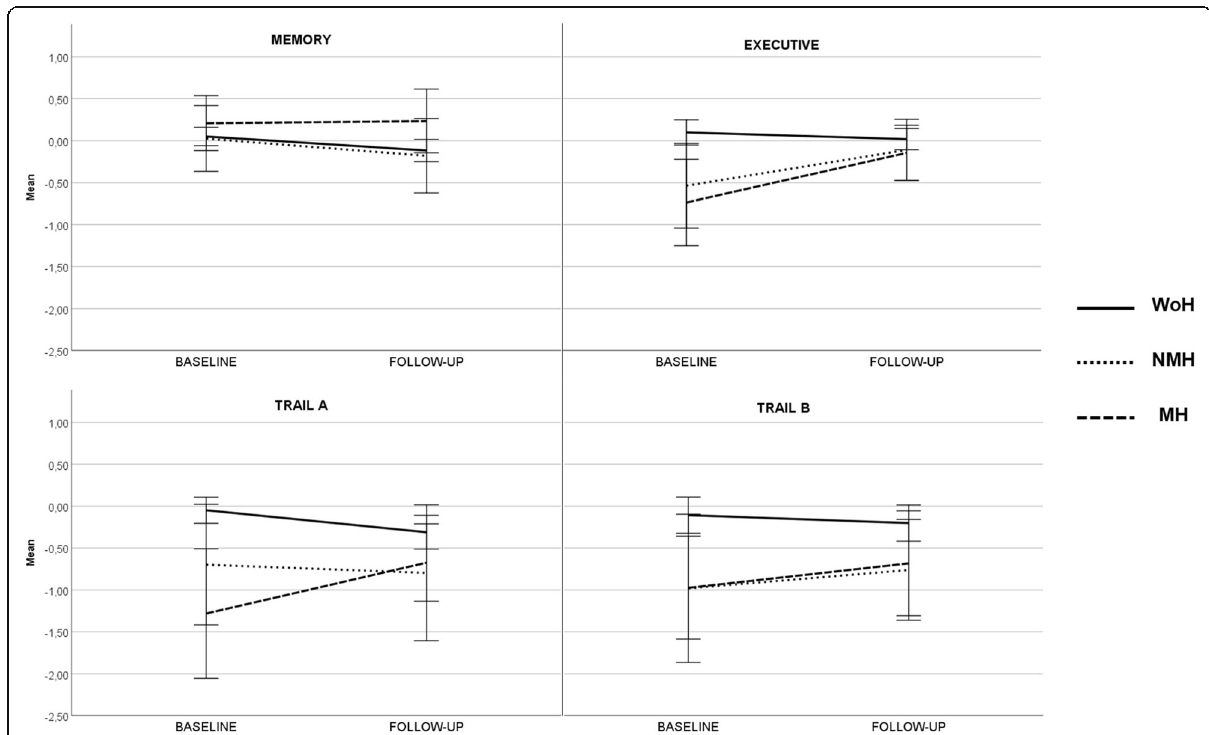
Fig. 3 Cognitive performance overtime by headache group. Legend: y-axis represent estimated marginal means memory and executive composite zscores and trail A and B zscores controlling for gender, age at baseline, depressive symptoms; WoH – without headache, NMH – non migraine headache, MH – migraine headache